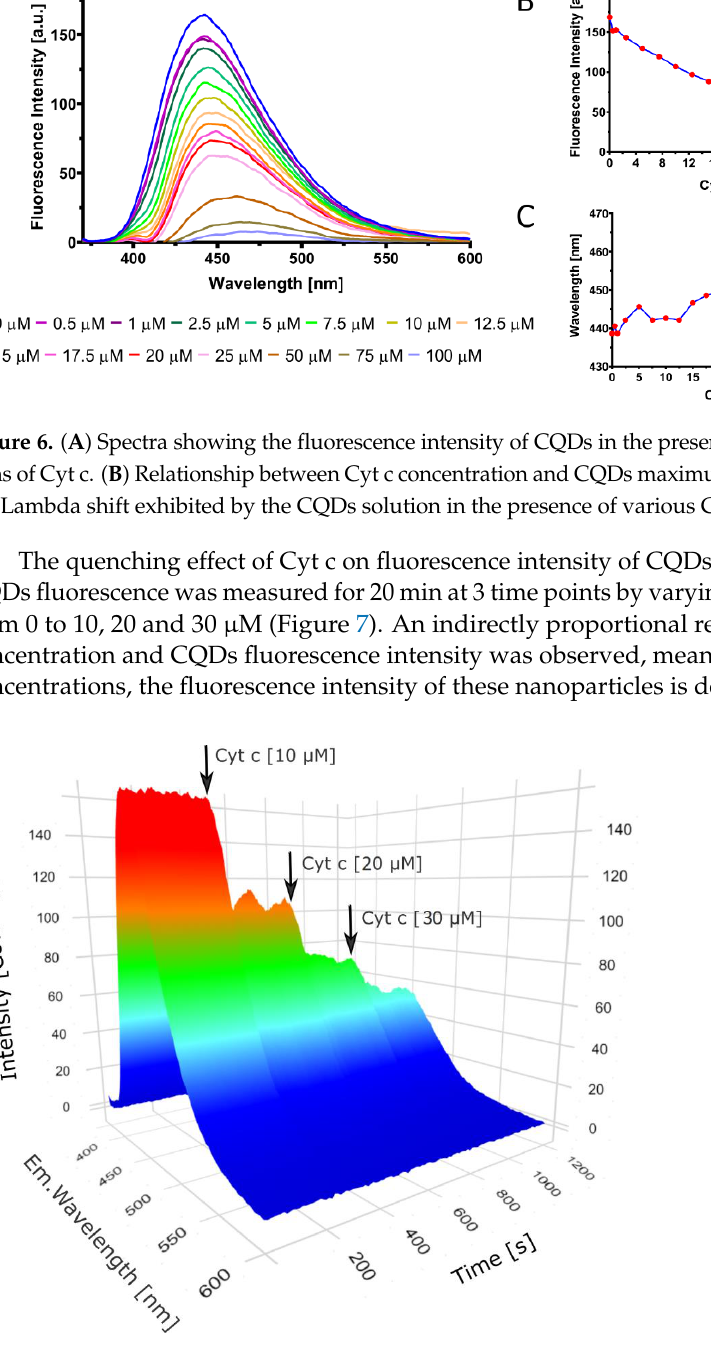
Figure 7. CQDs fluorescence intensity spectra variation in 20 min at different doses of Cyt c. Starting with 5 min time point, Cyt c was added, and the effects on fluorescence intensity were investigated for 5 min before increasing the dose.